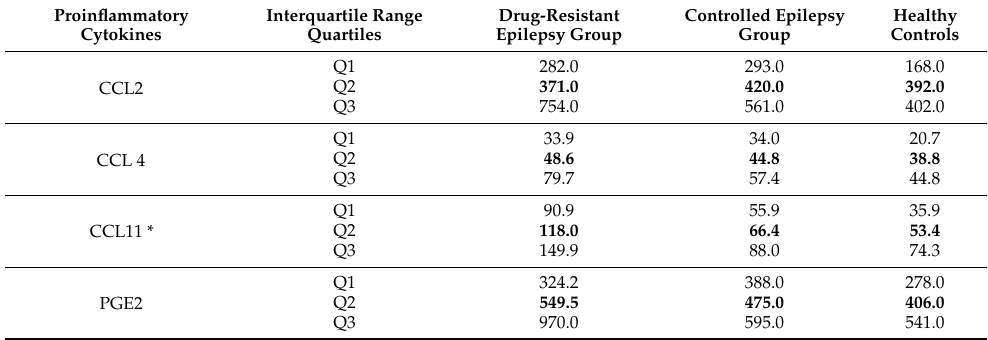
Table 3. The interquartile range (IQR) of targeted proinflammatory cytokine concentrations.